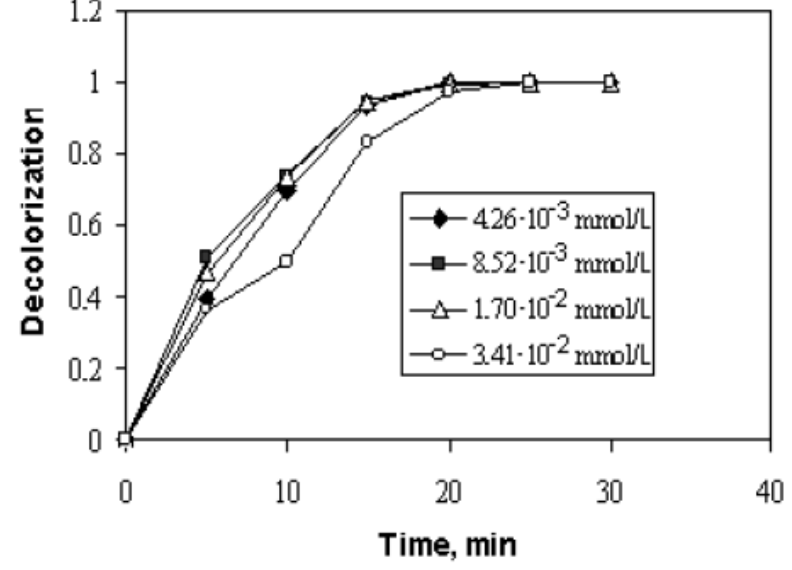
Fig. 14 Effect of Ni 2+ ions on AOP in neutral medium. Initial conditions: C dye =50 mg/L, [H 2 O 2 ]= 17.318